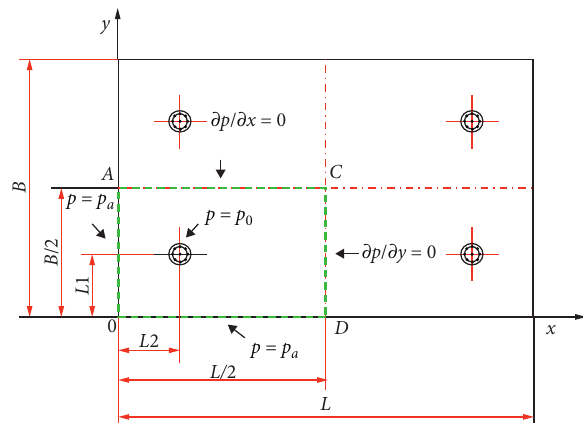
Figure 3: Schematic diagram of the boundary conditions in the computational